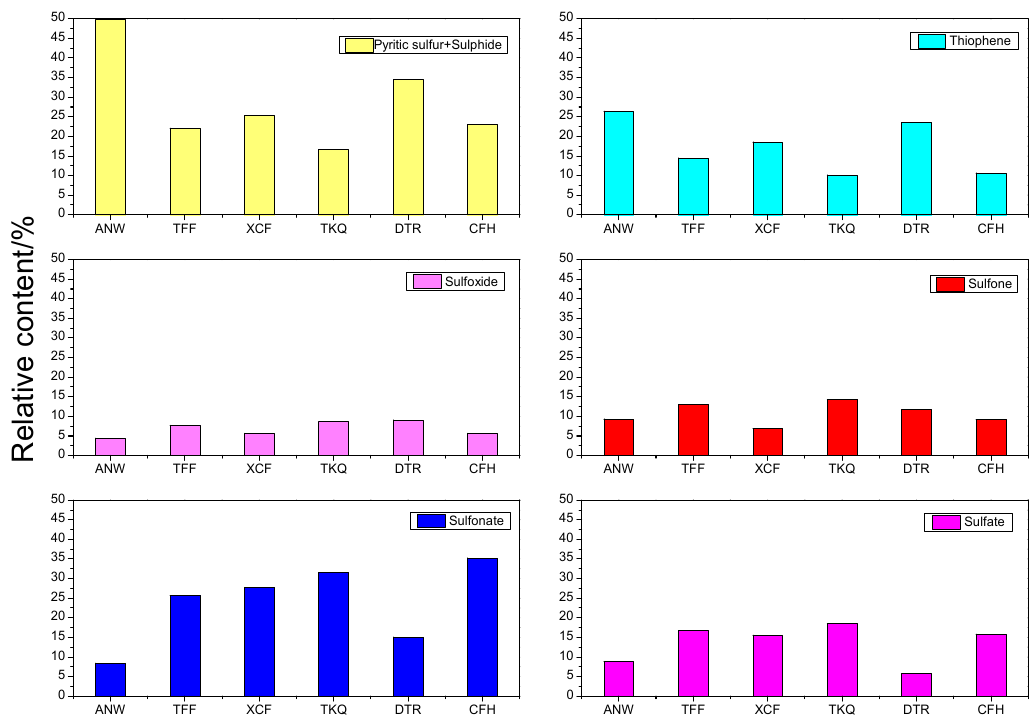
Figure 2. The relative content of different sulfur on six coal samples surface.